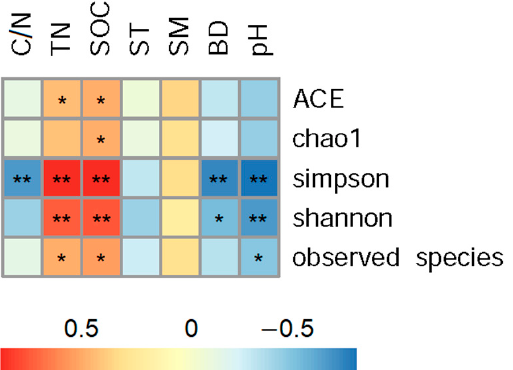
Figure 3. Correlation analysis between alpha diversity and soil characters across all land use patterns in Tianzhu alpine agro-pastoral ecotone. “*” indicates p < 0.05 and “**” indicates p < 0.01. SOC and TN represents soil organic carbon and total nitrogen contents; C/N means SOC and TN ratio; ST and SM represent soil temperature and moisture, and BD means bulk density.